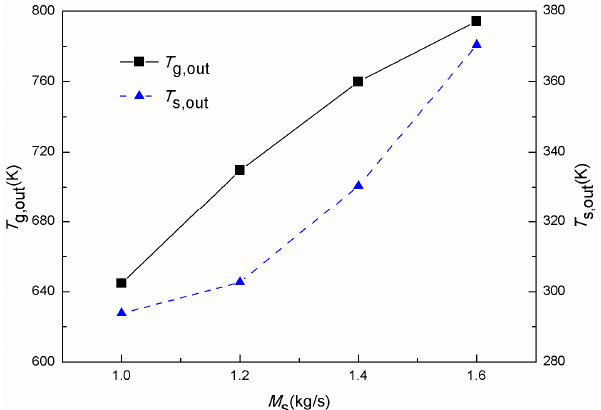
Figure 10. Influence of the sinter flow rate on the outlet air temperature and outlet sinter temperature.